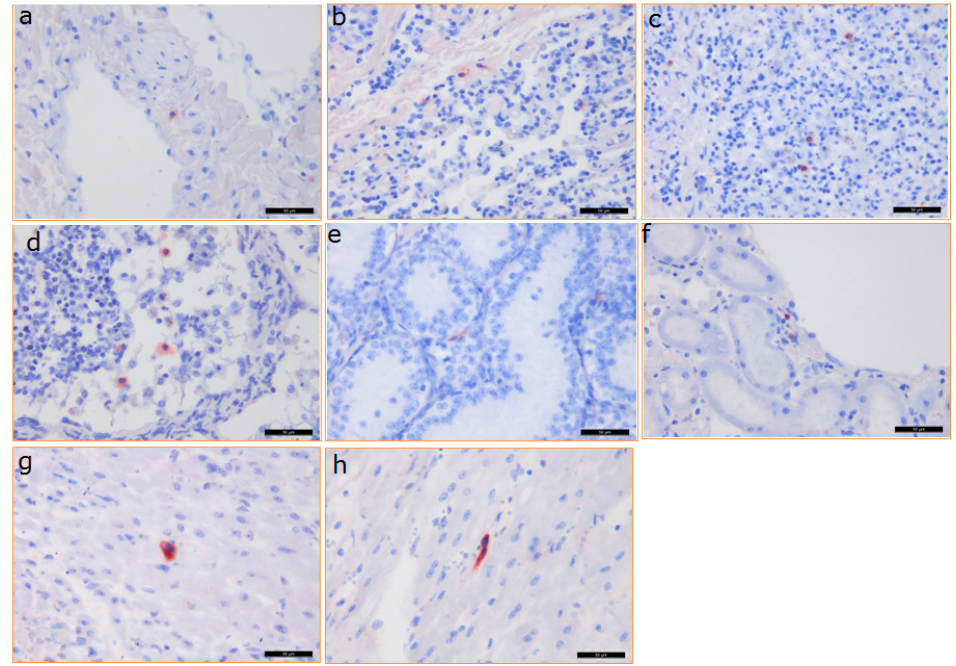
Figure 6. Immunohistochemical analysis of PCMV distribution in different organs of baboon 64. The same PCMV-specific rabbit serum was used as in Figure 5. a—baboon liver, b—baboon lung, c—baboon spleen, d—baboon lymph node, e—baboon testis, f—baboon kidney, g,h—pig heart. Scale bar = 50 µ